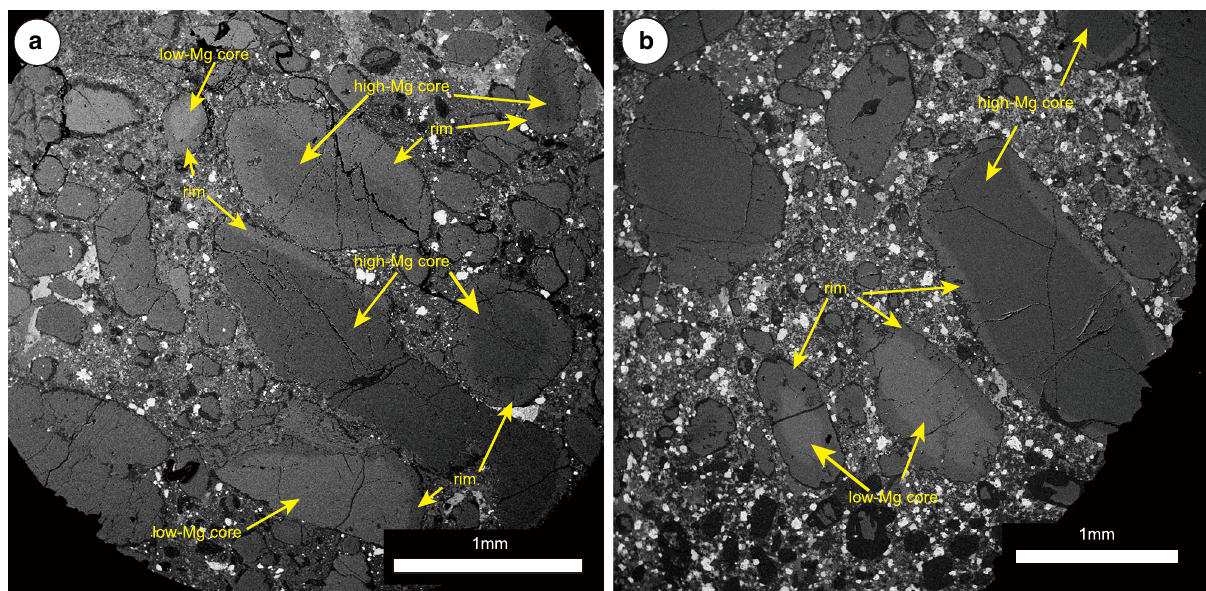
Fig. 1 Back-scattered electron (BSE) SEM imaging of olivine in kimberlites. a Karowe AK6 South pipe (Botswana); b P200 (Lesotho). Note the strong core-rim zoning in kimberlitic